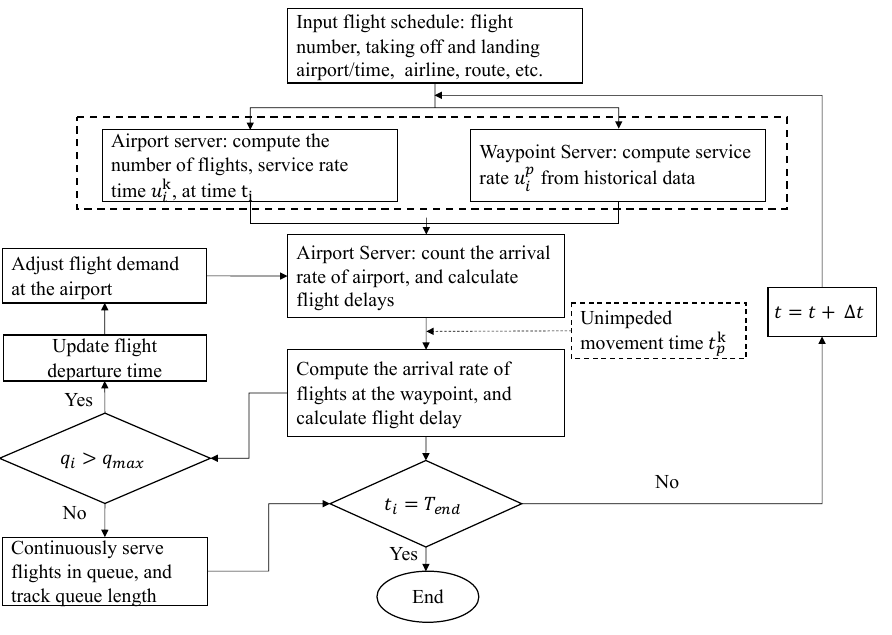
Figure 2. The overall flow chart of the